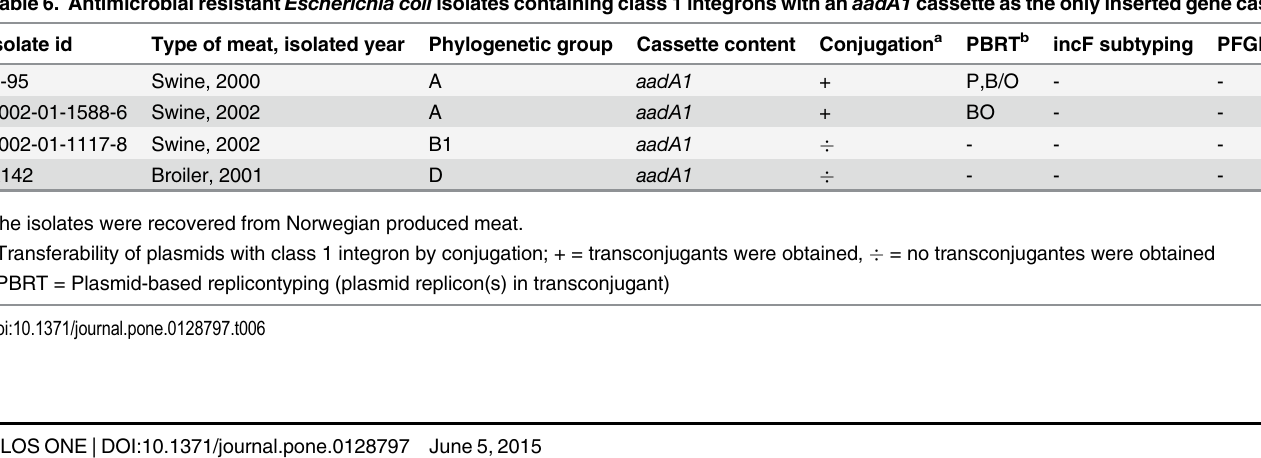
that was not investigated). PFGE was performed to investigate possible clonal relationship be- tween the human isolates harbouring this plasmid. Seven isolates produced banding patterns with more than 85% similarity suggesting a possible clonal distribution of this E . coli variant. The seven isolates originated from six different hospitals spread across Norway. Furthermore, one representative isolate (2003 3500827) was serotyped as O6:K5:H1 (SSI, Denmark), a sero- lated isolates were subjected to O6 specific PCR with a positive result. The remaining five isolates containing the particular plasmid produced distinct PFGE patterns indicating presence of the plasmid in unrelated host strains as well (Table 5).